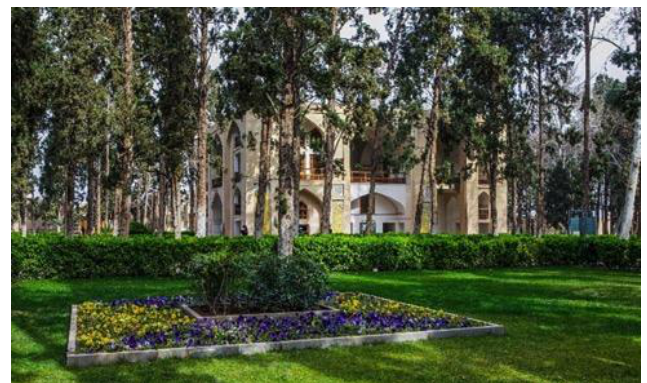
Figure 12. A view of natural environment of Fin garden. Kashan. Tall cypresses provide shades for most of the garden. The shrub roses, grass and violet flowers intensified the natural beauty of the garden. Photo by: Ni n ara from Flickr